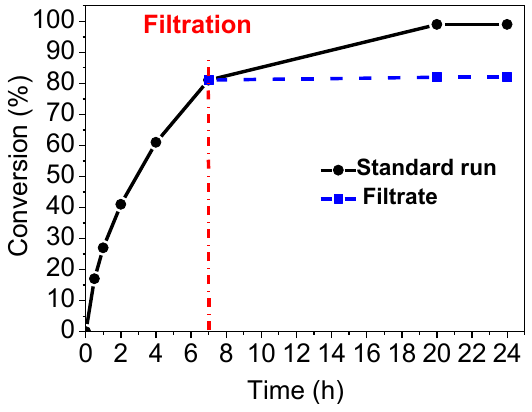
Figure 2. Conversion and hot filtration test during the Suzuki–Miyaura coupling reaction of 4-bromotoluene ( 1a ) with phenylboronic acid ( 2a ) over Pd/PVPy (see footnotes to Table 1 for experimental conditions).